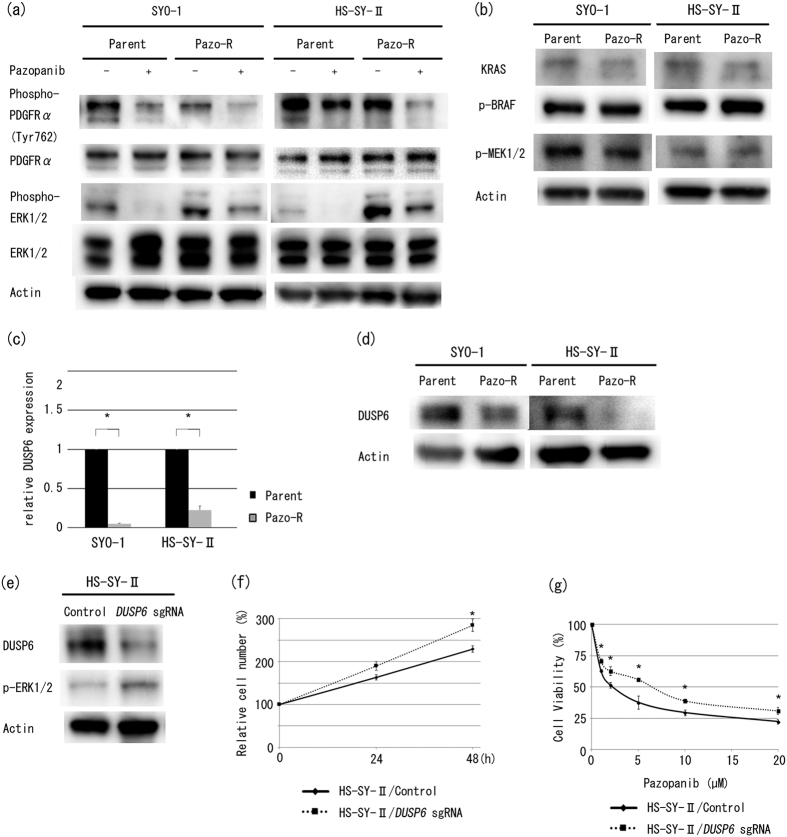
Mechanisms of increased phosphorylation of ERK1/2 in pazopanib-resistant SS cells.(a) Pazopanib-induced inhibition of phosphorylation of PDGFRα in SS clones was assessed by Western blot analysis with anti-PDGFRα, anti-phospho-PDGFRα, anti-ERK1/2, and anti-phospho ERK1/2 antibodies. SS clones were pre-treated with 5 μM pazopanib for 2 hours. (b) Phosphorylation of the RAS–RAF–MEK pathway in SS clones was assessed by Western blot analysis with anti-KRAS, anti-phospho-BRAF, and anti-phospho-MEK1/2 antibodies. (c) mRNA expression of DUSP6 was assessed by quantitative RT-PCR. Values represent mean ± S.D. *P < 0.05, vs parental clones. (d) Protein expression of DUSP6 was assessed by Western blot analysis with anti-DUSP6 antibodies. (e) Protein expression of DUSP6 and phosphorylation of ERK1/2 in HS-SY-II control and CRISPR-treated cells were assessed by Western blot. (f) Control and CRISPR-treated HS-SY-II cells were incubated for 48 hours. The relative number of viable cells was evaluated by CellTiter-GloTM Luminescent Cell Viability Assay. (g) Control and CRISPR-treated HS-SY-II cells were incubated with various doses of pazopanib for 48 hours. Viable cells were counted using a Z1 Coulter particle counter. Values represent mean ± S.D. *P < 0.05; **P < 0.01, vs control clones. Pazo-R represents pazopanib-resistant clone, and DUSP6 sgRNA represents CRISPR-treated cell.